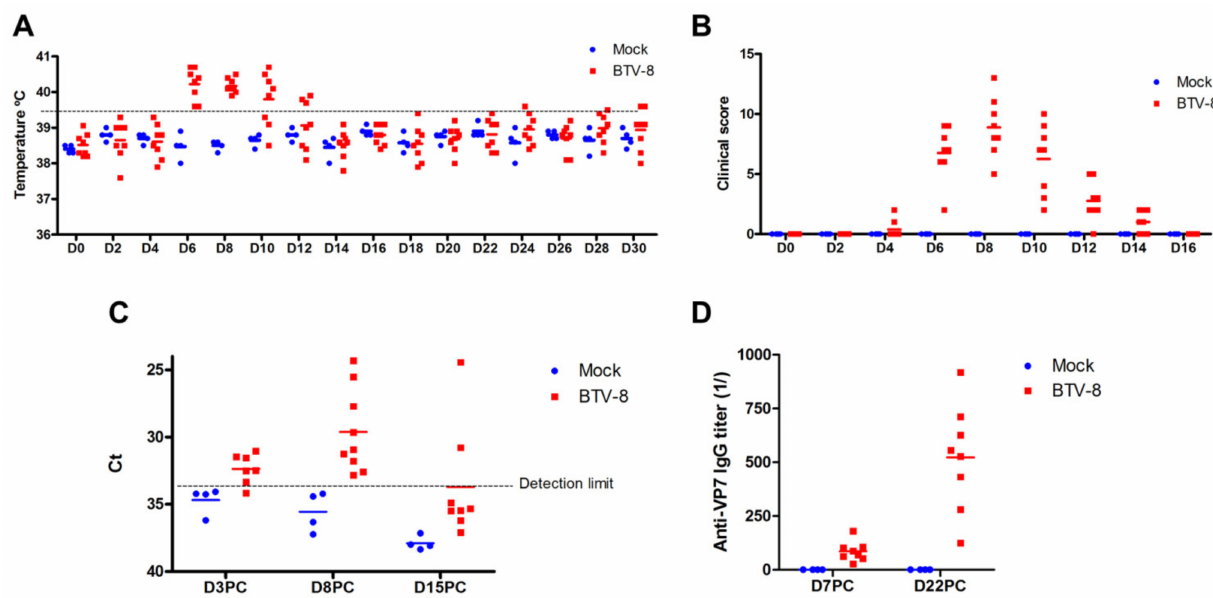
Figure 2. Assessment of BTV experimental infection in sheep: an example of BTV-8 infection in sheep. Sheep were experimentally infected intradermally with 2 × 10 6 pfu BTV-8 ( n = 8) or mock infected as control ( n = 4). ( A , B ) BTV-8 infected sheep developed ( A ) fever and ( B ) characteristic clinical signs (pyrexia, apathy, loss of appetite, depression, oro-mucal lesions . . . ) which were scored. ( C ) qPCR showed the presence of viral RNA in blood in 7 out of 8 infected sheep from day 3 post-challenge (D3PC). BTV RNA was detected in blood in all sheep at day 8 post-challenge (D8PC), while viremia was maintained up to day 15 post-challenge (D15PC) in 2 animals. ( D ) Seroconversion of BTV-8 infected sheep assessed by anti-VP7 ELISA. Anti-VP7 IgG are detectable at day 7 post-challenge (D7PC). Antibody titers increased by day 22 post-challenge (D22PC) in all infected sheep but titers are widely spread ranging from 1:125 up to 1:918. Detailed methodology can be found in Supplemental File S1 and in the following works